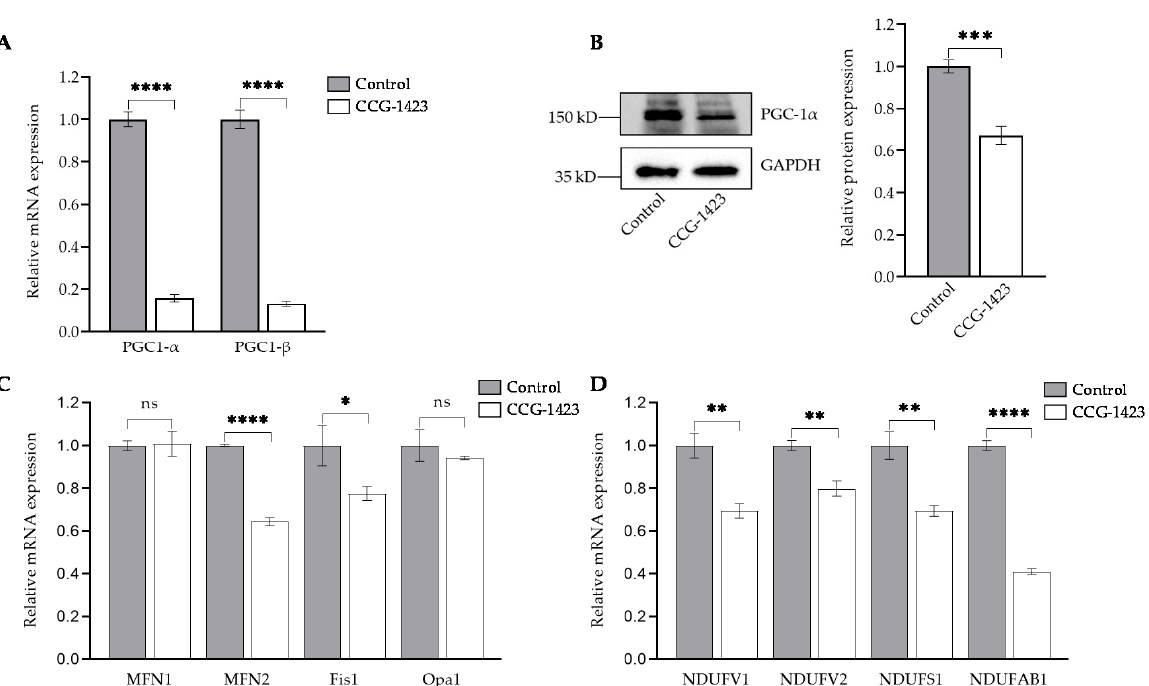
Figure 3. Repression of mitochondrial genes involved in biogenesis and function. ( A ) RT-qPCR analysis demonstrated the inhibition of PGC-1 α and -1 β gene expression following the treatment of CCG-1423. ( B ) Protein levels of PGC-1 α were analyzed by Western blot and GAPDH was used as a loading control. Densitometric analysis shows inhibition of PGC-1 α . ( C ) MFN2 and Fis1 gene expression levels reduced whereas MFN1 and Opa1 were unaffected. ( D ) Downregulation of mitochondrial genes involved in complex-I. * p < 0.05, ** p < 0.01, *** p < 0.001, **** p < 0.0001, ns: p > 0.05 ( n =